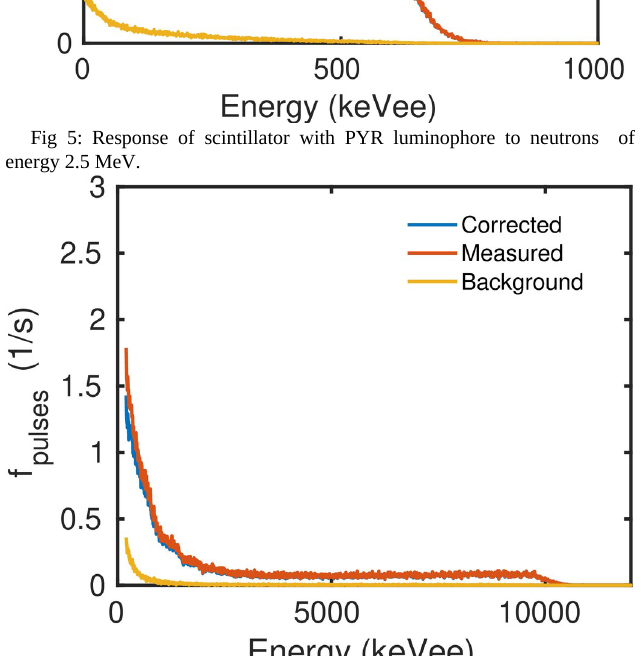
Fig 6: Response of scintillator with PYR luminophore to neutrons of energy 19 MeV. The simulated deposited energy for neutrons of energy 1.5 and 2.5 MeV using GEANT4 are shown in Figures 7 and 8.